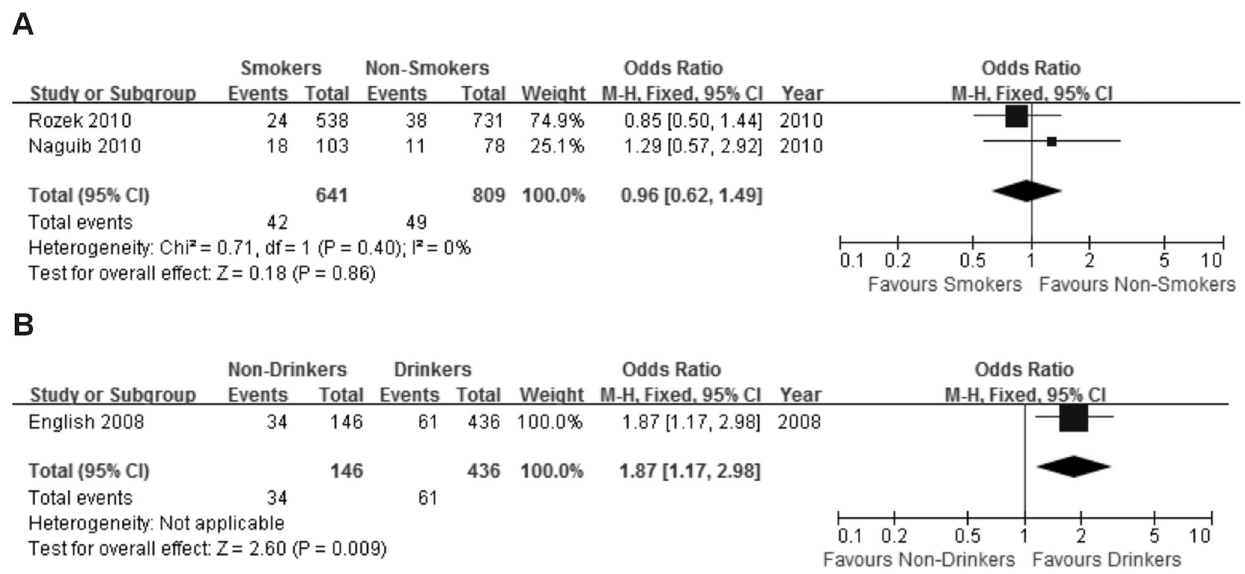
Figure 3. The association of BRAF V600E mutation with life style. Fixed effects model of the odds ratios (ORs) with 95% confidence intervals (CIs) of the association of BRAF V600E mutation with smoking (A) and alcohol consumption (B).